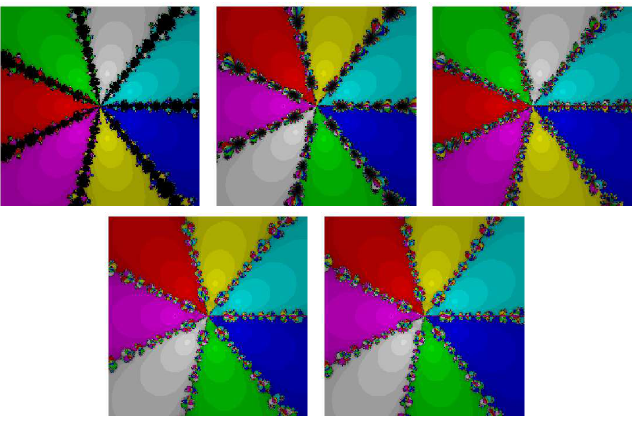
Figure 6. The basins of attraction for SM 4 , ZM 4 , SSM 4 , LM 4 and OM 4 , from left to right and top to bottom, respectively in Problem